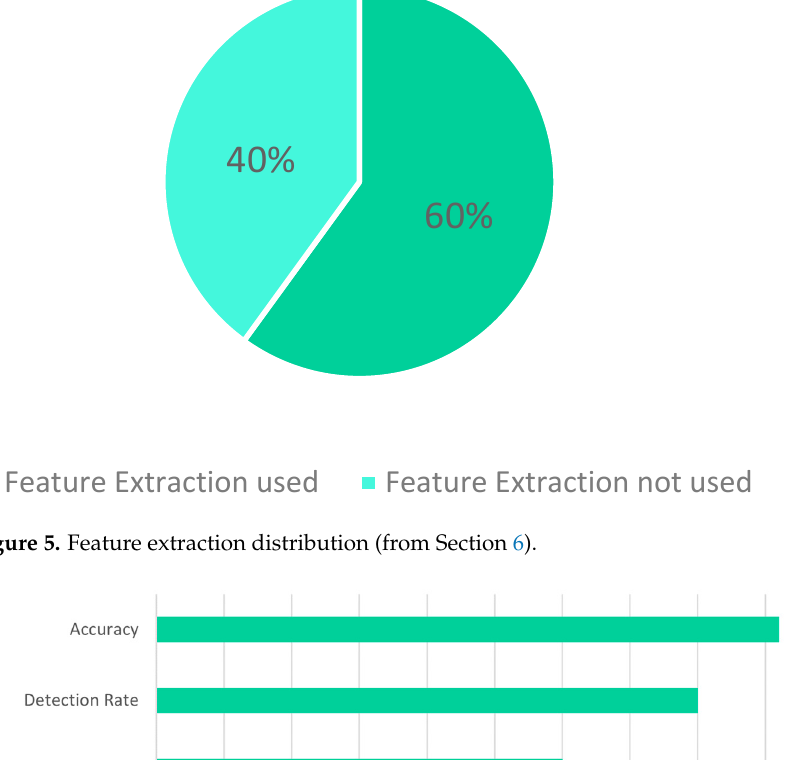
Figure 5. Feature extraction distribution (from Section 6).